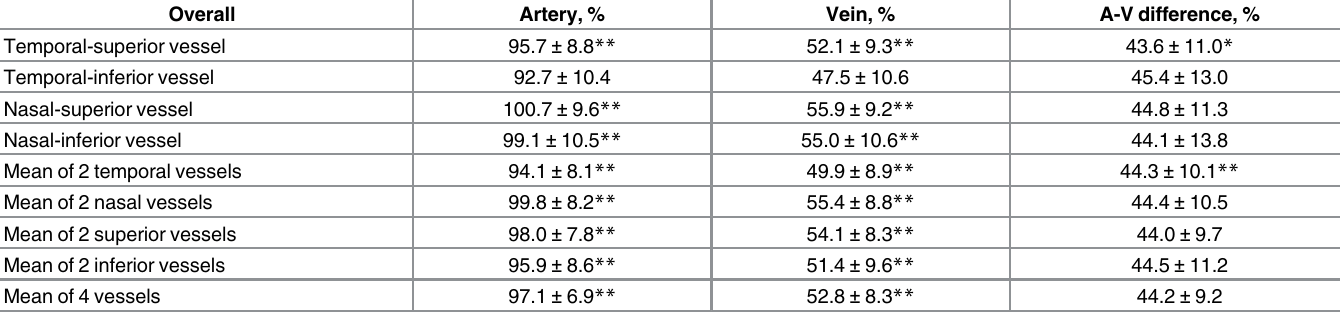
Table 2. Oxygen Saturation in Major Retinal Vessels in a Healthy Japanese Population Measured by Oxymap T1.